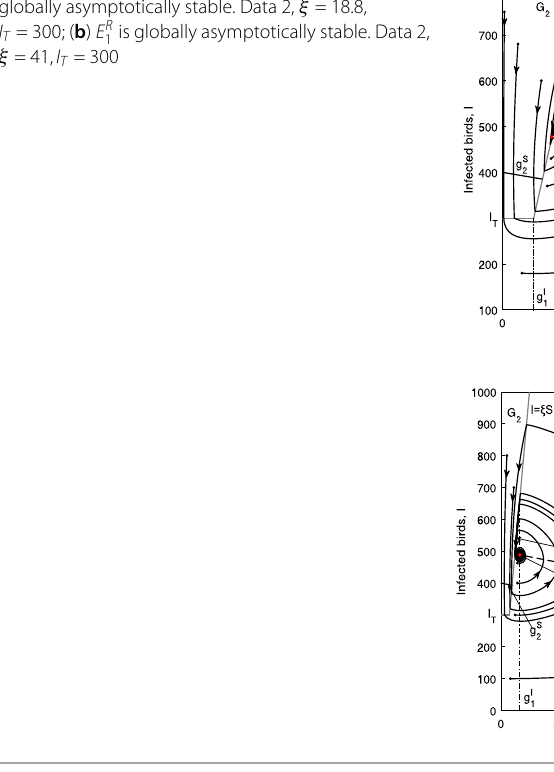
Figure 10 Global dynamics in Case C.2: ( a ) E p 2 is globally asymptotically stable. Data 2, ξ =